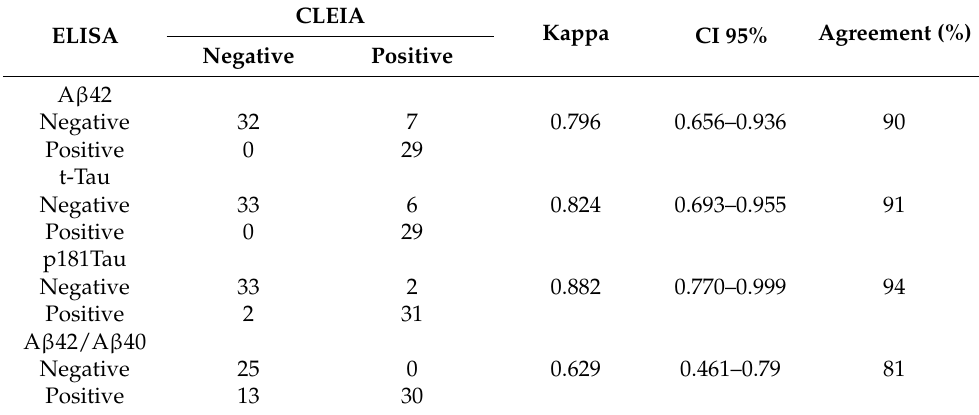
Table 3. Agreement of single biomarkers and A β 42/A β 40 ratio measured by ELISA and CLEIA immunoassays. CLEIA ELISA